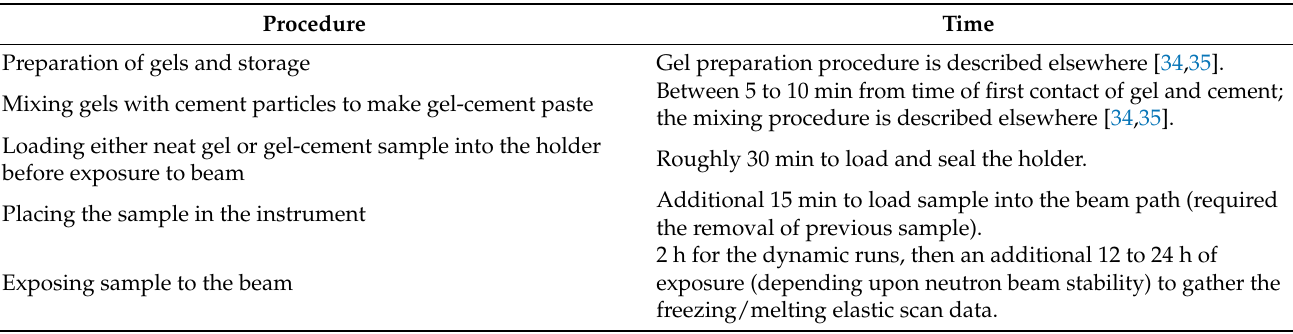
Table 2. Timeline for the sample preparation and data collection for experiments at